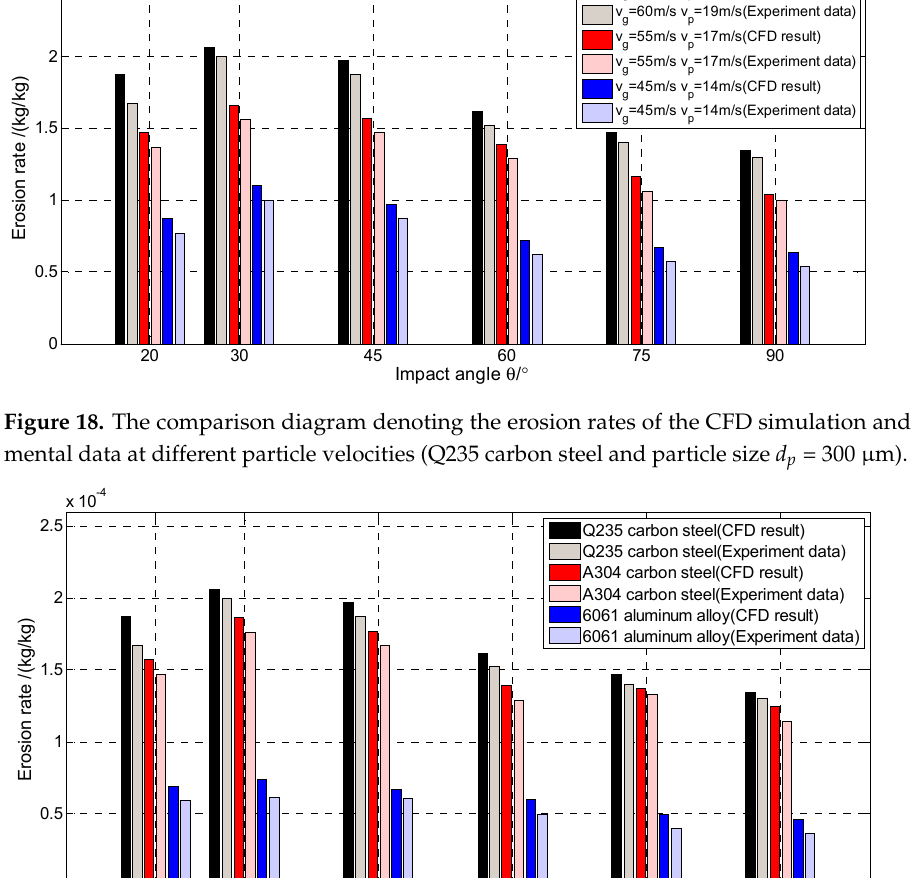
Figure 19. The comparison diagram denoting the erosion rates of the CFD simulation and experimental data of different materials (gas velocity v g = 60 m/s and particle size d p = 300 μ m).